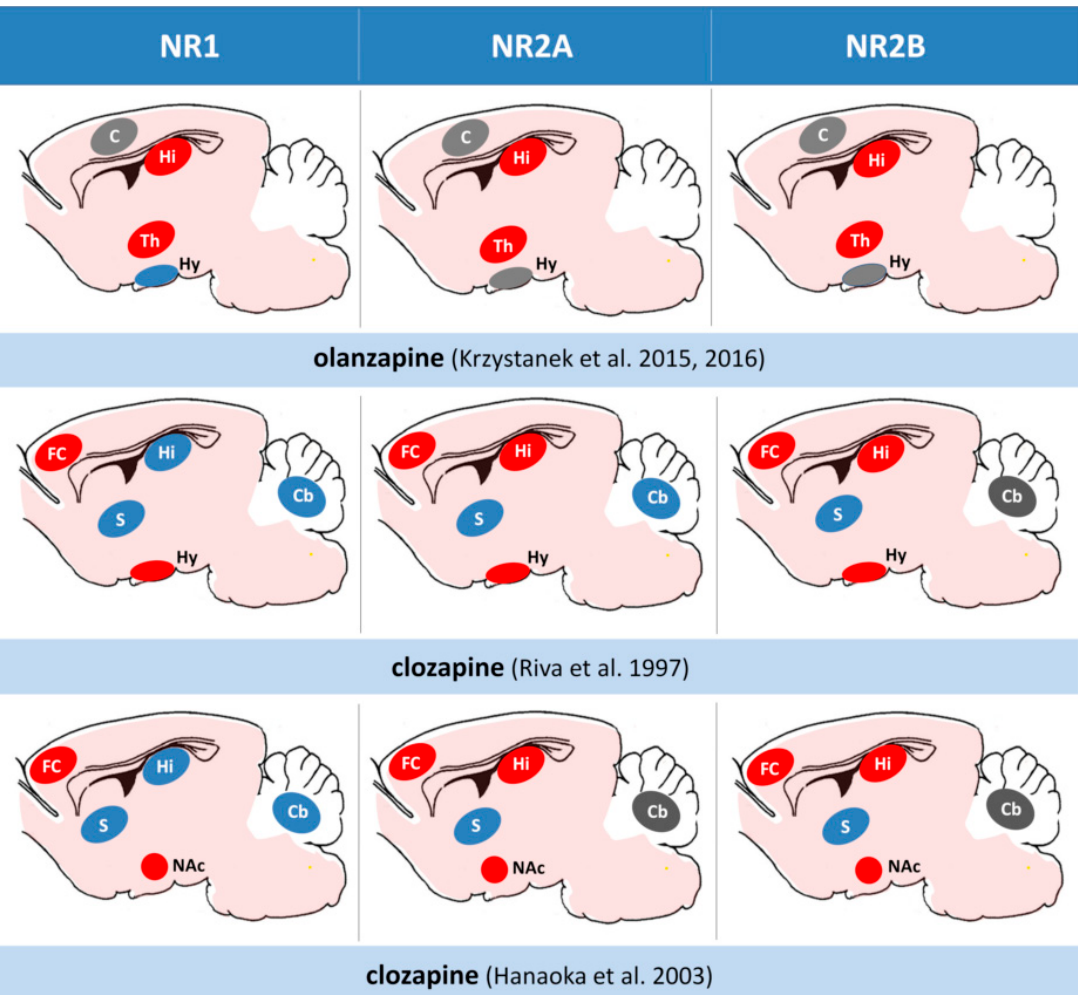
Figure 4. A comparative effect of second-generation antipsychotics on the NMDA receptor subunits expression in the rat brain. A comparative juxtaposition of the main studies in the field depicting brain structures with decreased (red) or increased (blue) NMDR subunit expression. Changes statistically not significant or no data in gray. Hi; hippocampus, FC; frontal cortex, PC; parietal cortex, Th; thalamus, Hy; hypothalamus, S; striatum, NAc; nucleus accumbens, Cb; cerebellum.